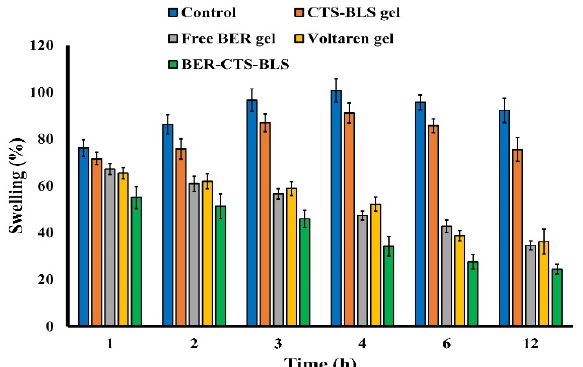
Figure 8. Percentage swelling in the untreated (Control), CTS-BLS gel (empty nanoparticles), free BER gel, Voltaren ® emulgel, and the optimized BER-CTS-BLS formulation group in carrageenan-induced paw edema rat model.